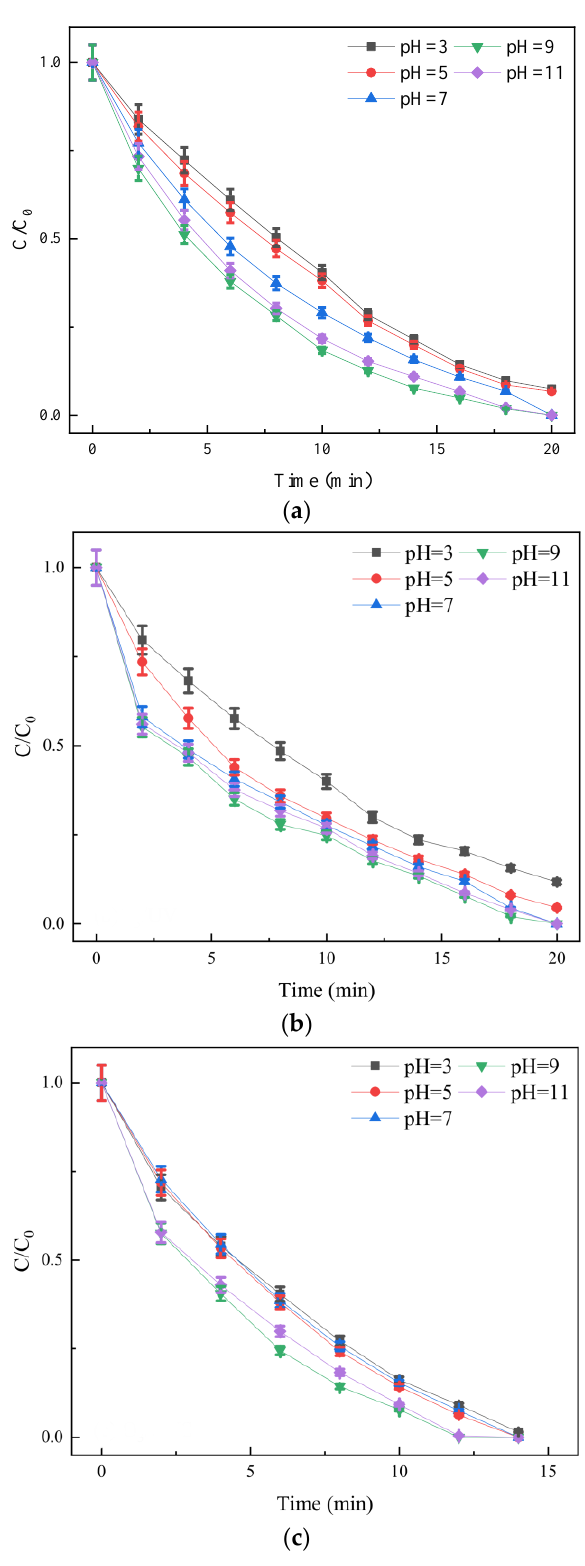
Figure 6. Effect of pH on SDZ degradation in O 3 , O 3 /UV, and O 3 /PMS processes (reaction conditions: pH = 3, 5, 7, 9, 11, SDZ = 10 mg/L, O 3 = 3 mg/L, T = 25 ± 0.5 ◦ C, O 3 = 3 mg/L, PMS = 22.8 mg/L, UV = 0.9 mw/cm 2 ). ( a ) O 3 , ( b ) O 3 /UV, ( c ) O 3